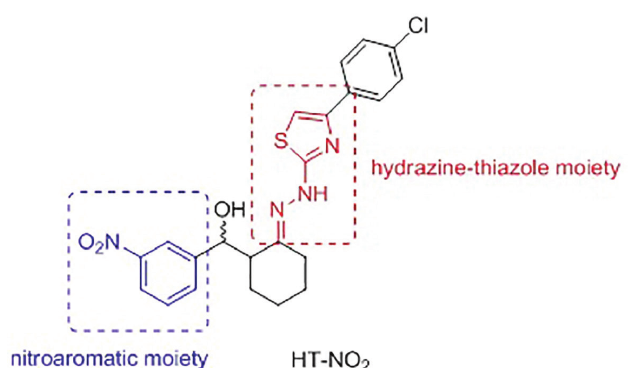
FIGURE 3 - Chemical structure of the hybrid molecule synthesized in this